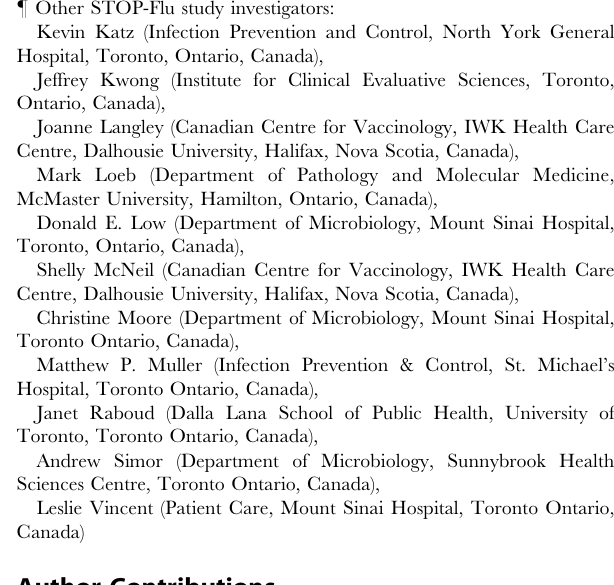
The seven discrepant swabs included five different viruses (Figure 1). Considering a virus identified by PCR from either type of swab as valid, the sensitivity and negative predictive values of mid-turbinate and nasopharyngeal swabs are shown in Table 1.